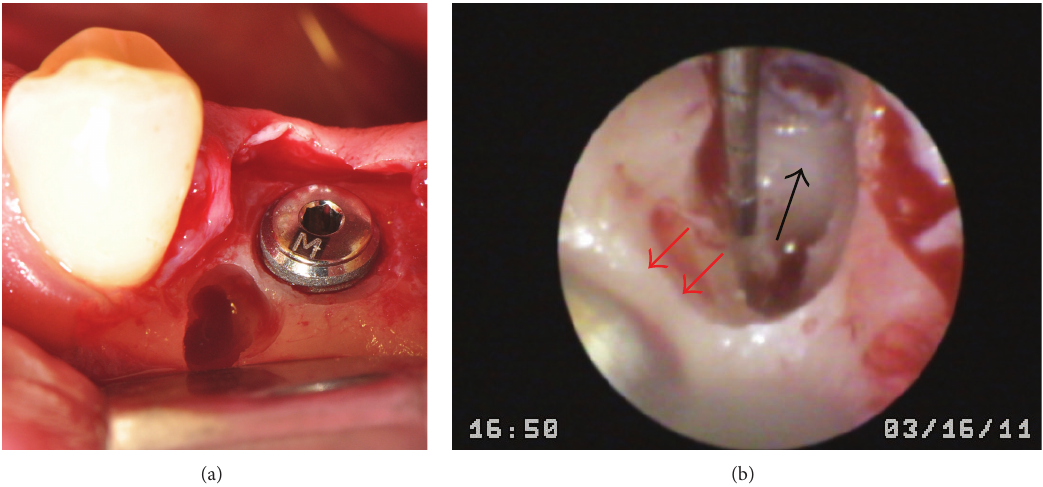
Figure 5: Total removal of supernumerary tooth (a). Support endoscope (SE) or macroscopic endoscopic control; note the integrity of the buccal cortex (red arrows) and no communication with the implant (black arrow) (b).